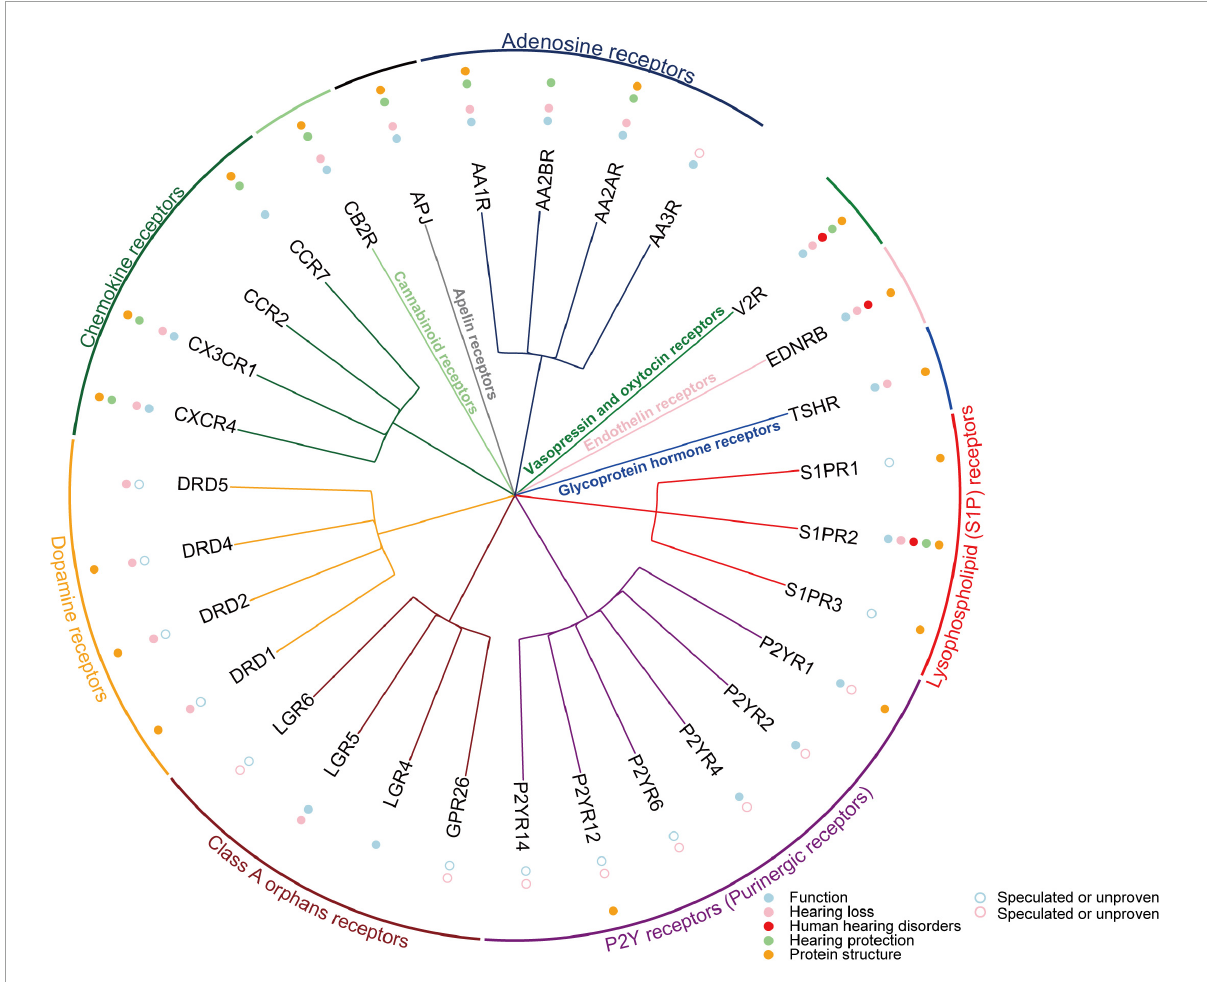
FIGURE2 The summary of reported 30 Class A GPCRs in cochlea. The blue circle indicates that GPCR are functional in the cochlea. Pink circle indicates GPCR associated with hearing loss. Red circle indicates GPCR associated with human hearing disorders. Green circle indicates GPCR involved in hearing protection. The orange circle indicates that the GPCR has resolved the protein structure. Open circles indicate conjectures or confirmed